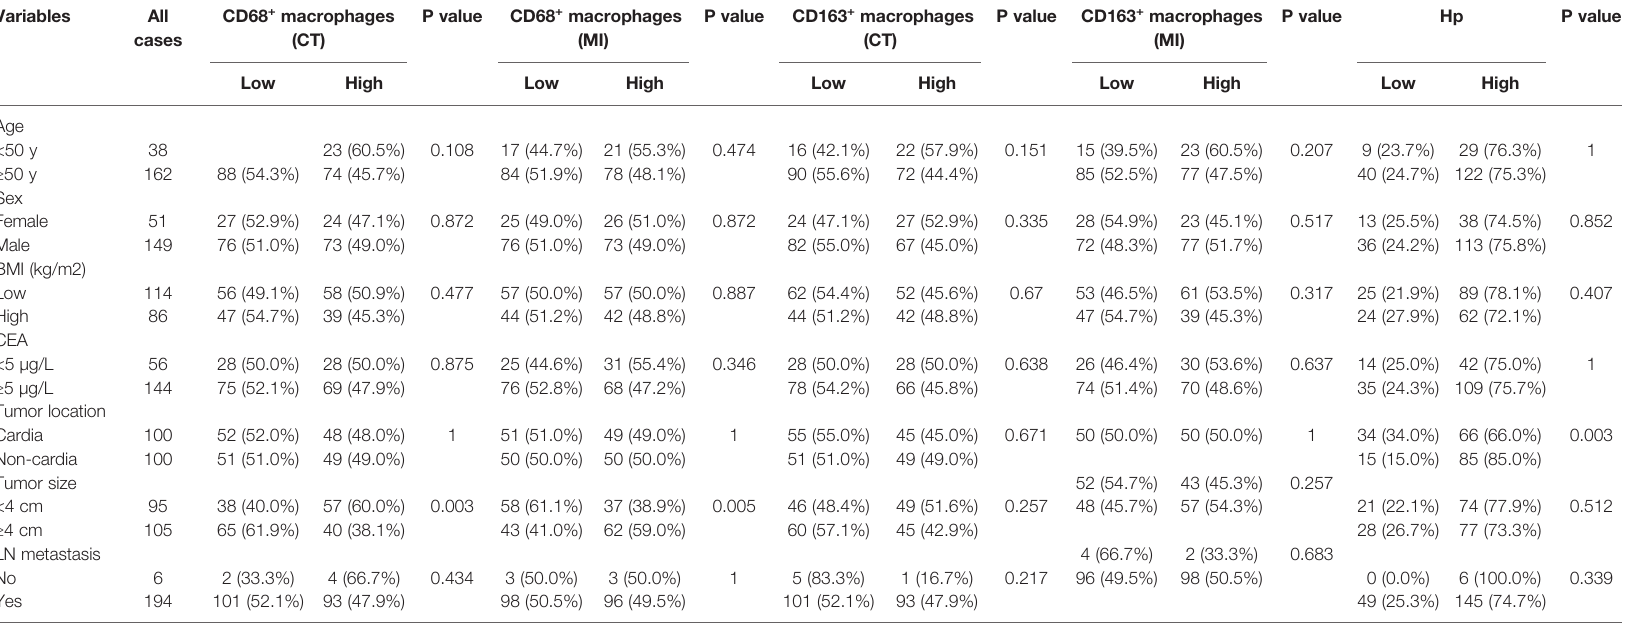
TABLE 1 | Correlation analysis between macrophages, Hp infection and clinicopathologic features of the patients with gastric cancer.